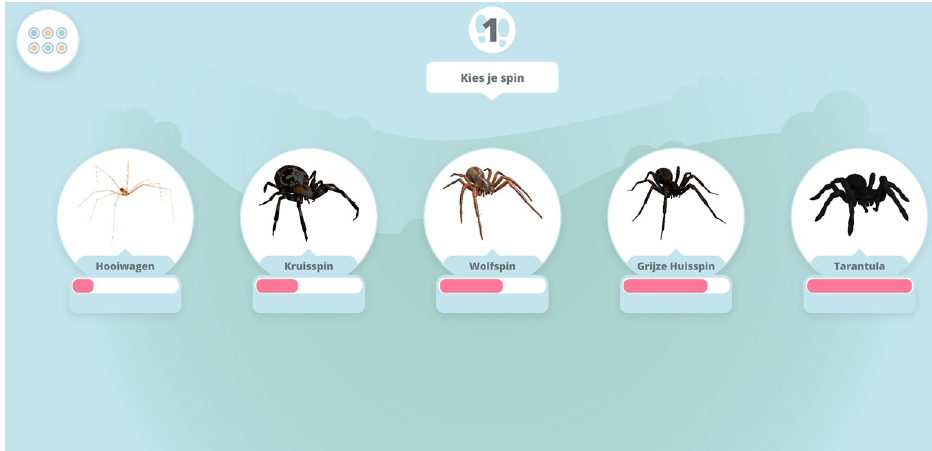
Fig 5. Spider selection screen.